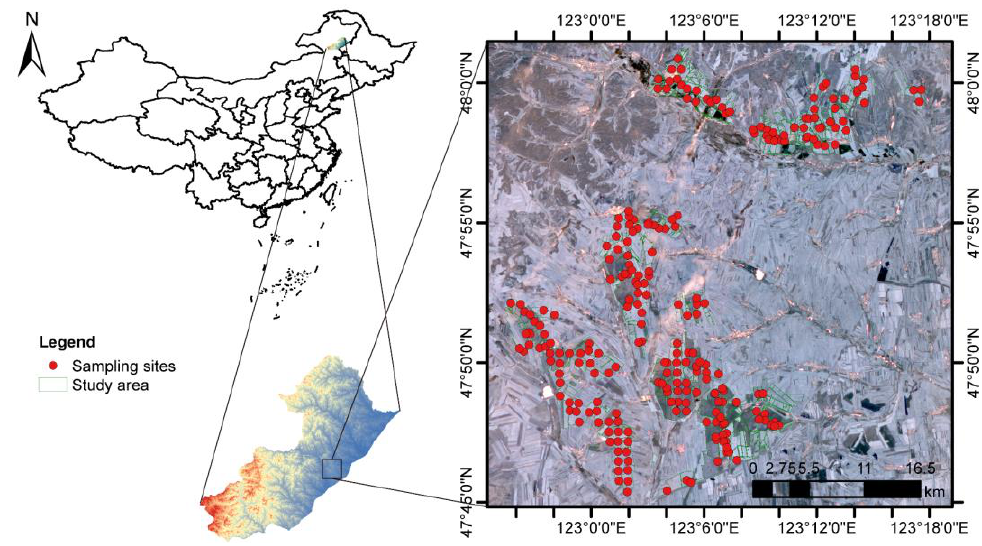
Figure 1. The geographic location of the study area and the distribution of the soil sampling sites.